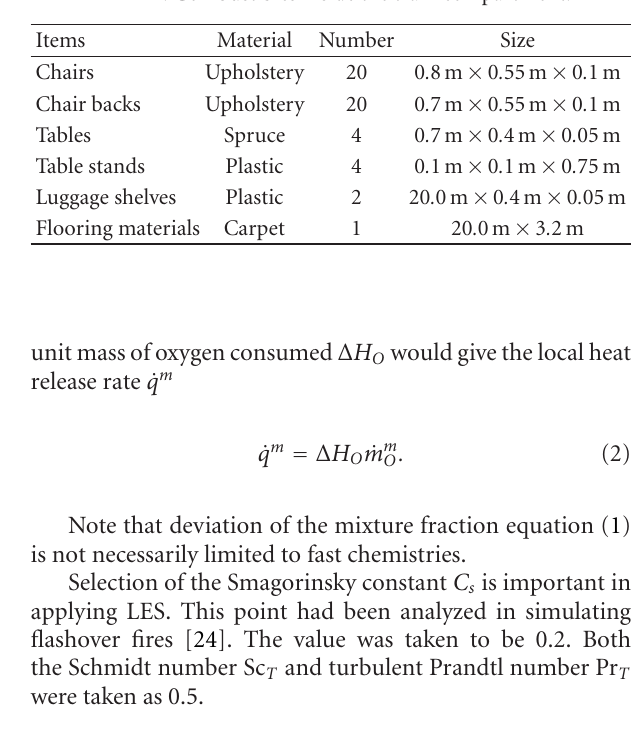
Figure 4: Temperature distributions on the plane y = 6 . 7 m across the fire. Table 1: Combustibles inside the train